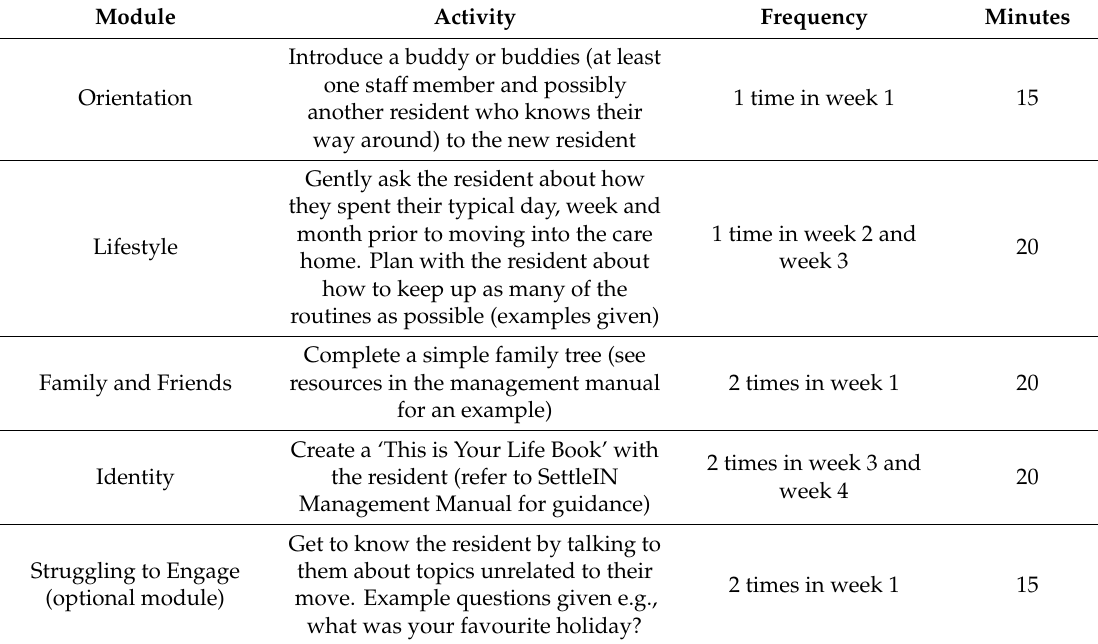
Table 3. Examples of an activity from each of the five SettleIN